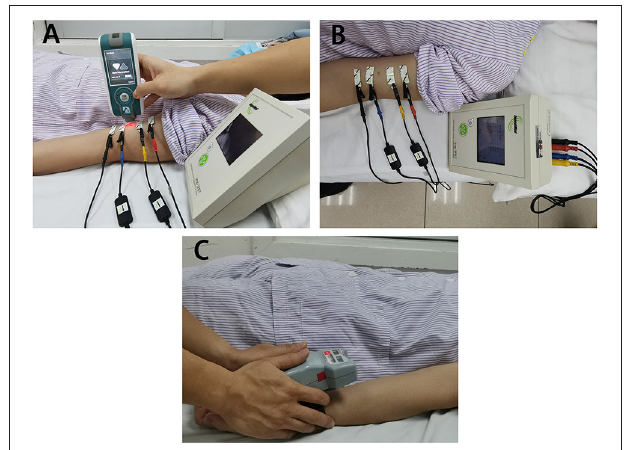
FIGURE 1 | The apparatus for measurement adopted in the study. (A) The test location and electrical impedance myography, (B) Myotonometer to measure muscle mechanical properties. (C) Handheld dynamometer to record muscle